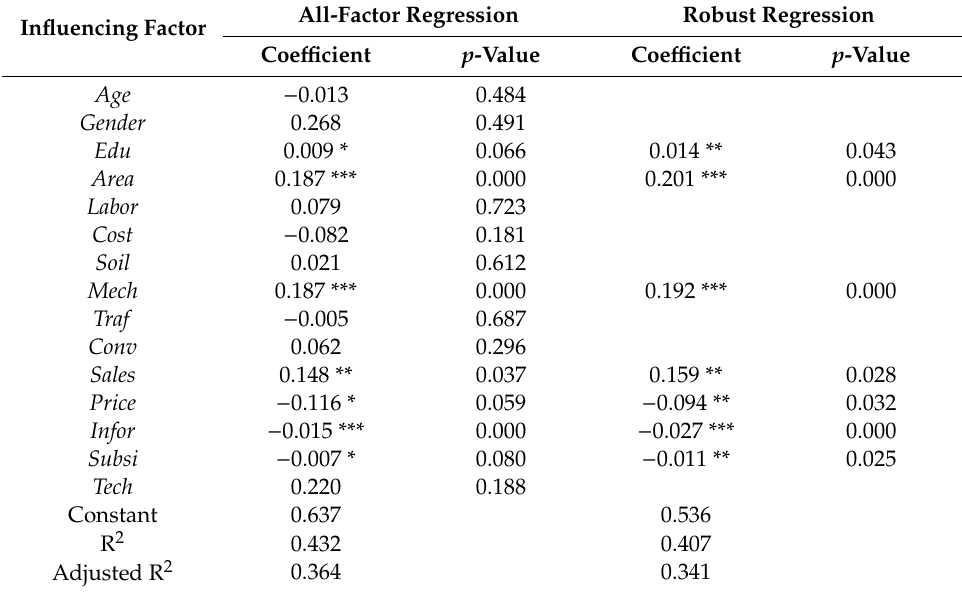
Table 7. The result of Tobit regression